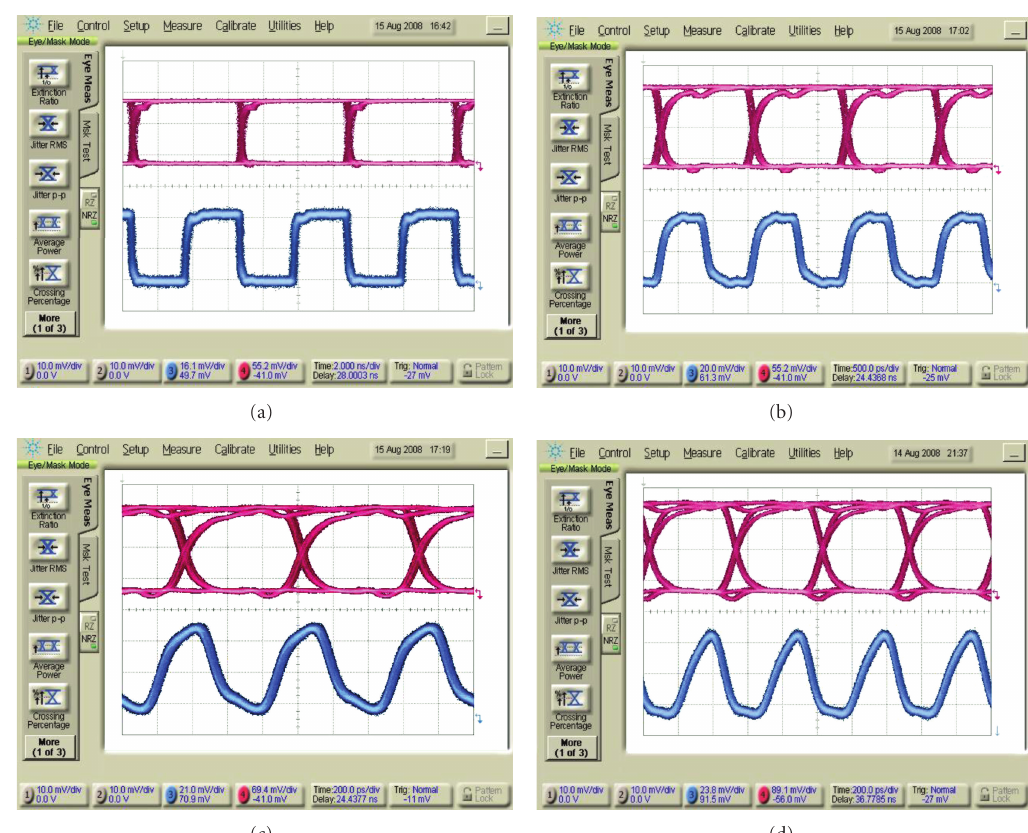
Figure 8: Measured eye diagrams and clock @650 Mb/s (a), 3Gb/s (b), 6Gb/s (c) and 8 Gb / s